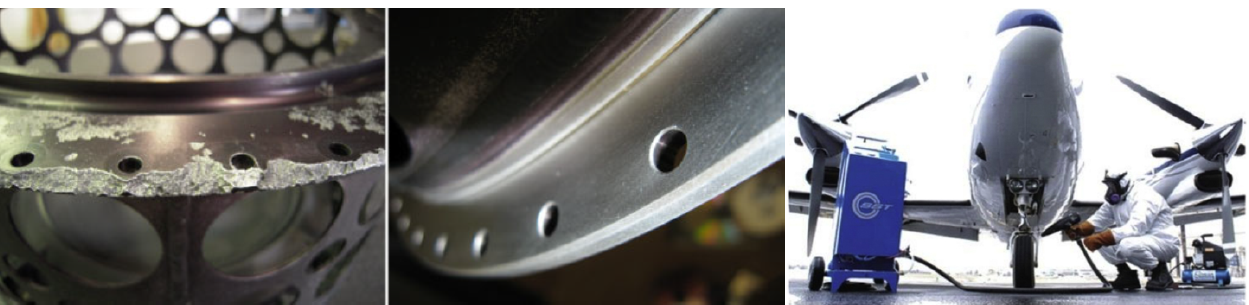
Figure 8. CS technology to repair aviation parts ( left : before repair, middle : after repair) [72] and on-site repair of aircraft landing gear ( right ) [73].